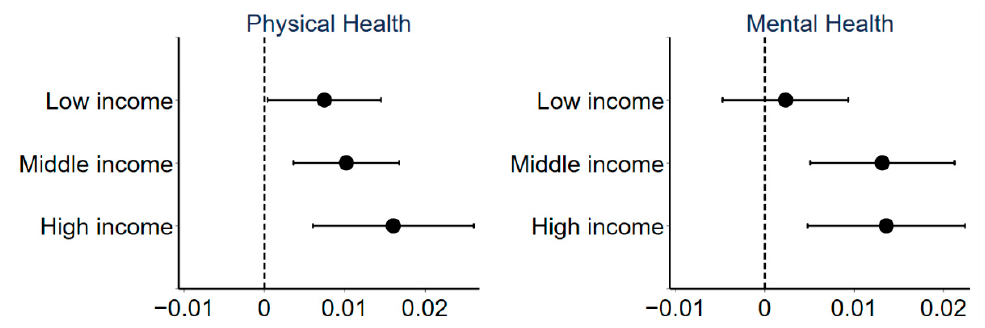
Figure 6. Coefficients and 90% confidence intervals of regressions for different income groups.